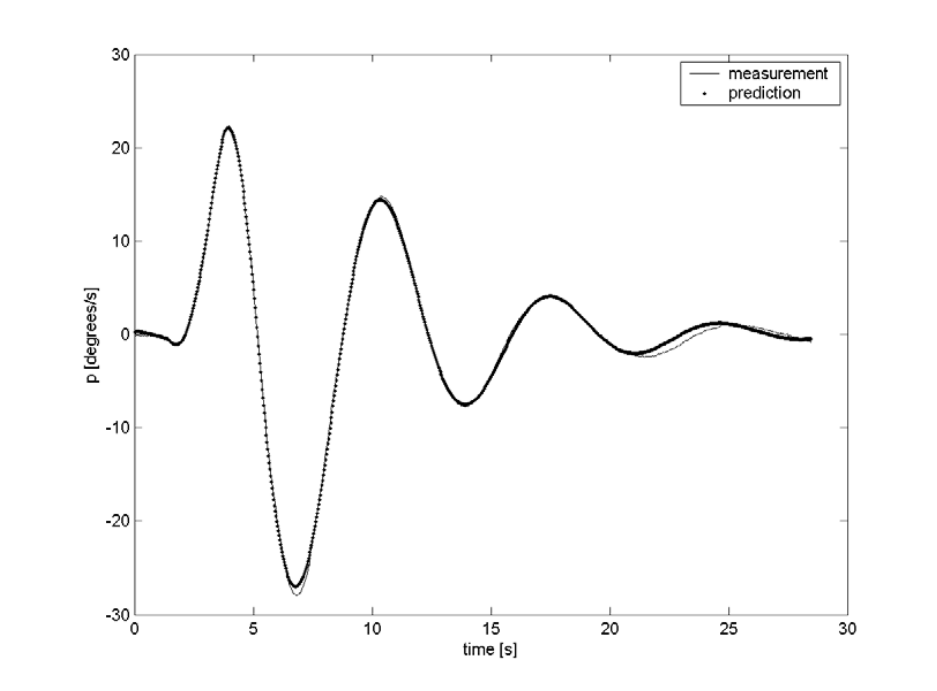
Fig. 9. Measured roll angular rate and estimated